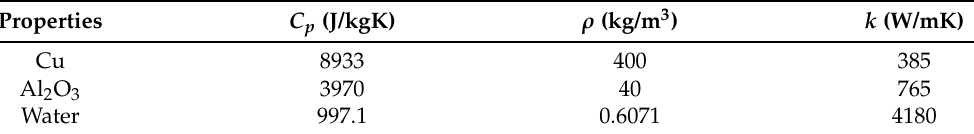
Table 2. Physical properties of nanoparticles and the regular fluid